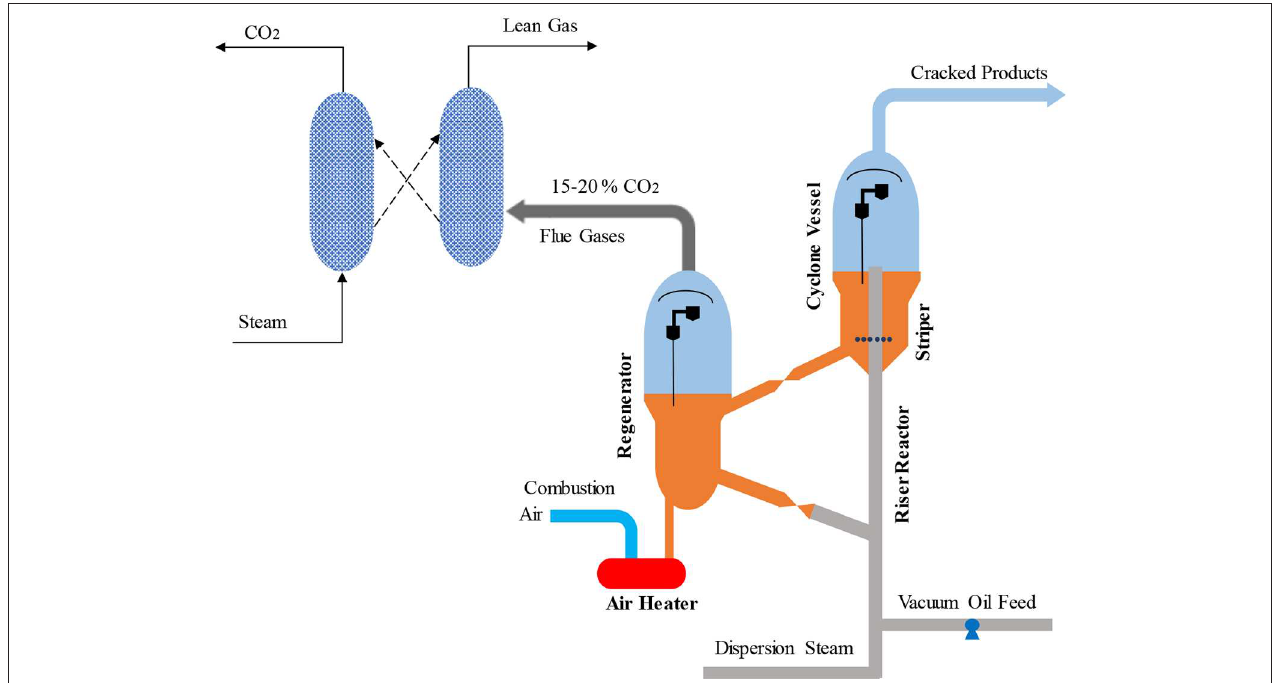
FIGURE 4 | Post-combustion capture for a FCC, adapted from Miracca and Butler (2015) with permission from BP Group Technology.